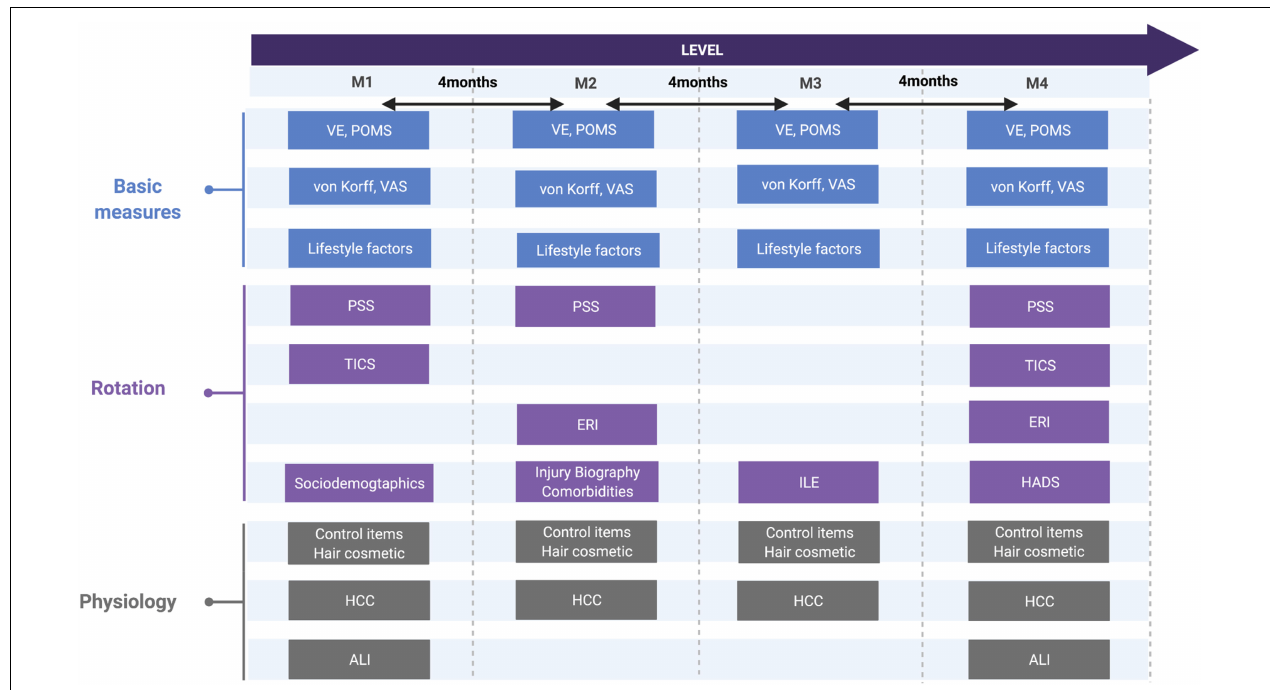
FIGURE 2 | Study design regarding psychometric and biological measures and its rotation. von Korff, CPG, chronic pain grade questionnaire; VAS, visual analog scale; VE, vital exhaustion, TICS: trier inventory of chronic stress; PSS, perceived stress scale; ERI, effort-reward-imbalance; ILE, inventory of life-changing events; POMS, profile of mood status; HADS, hospital anxiety depression scale, sociodemographic and lifestyle factors, hair cosmetic, comorbidities, ALI, allostatic load index; HCC, hair cortisol concentration.